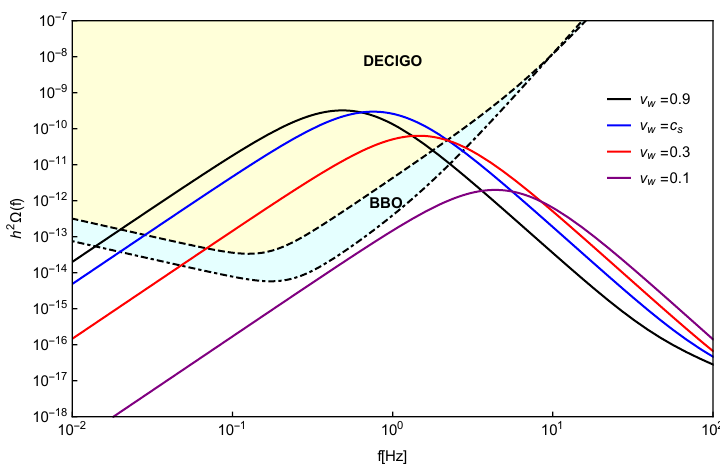
Figure 5 . GW energy density spectra of the first order PQ PT with f a = 100 TeV for different bubble wall velocities are displayed. Dashed curves are the expected sensitivity curves of proposed space-based DECIGO and BBO detectors [59, 60], which may probe the generated GW signals.